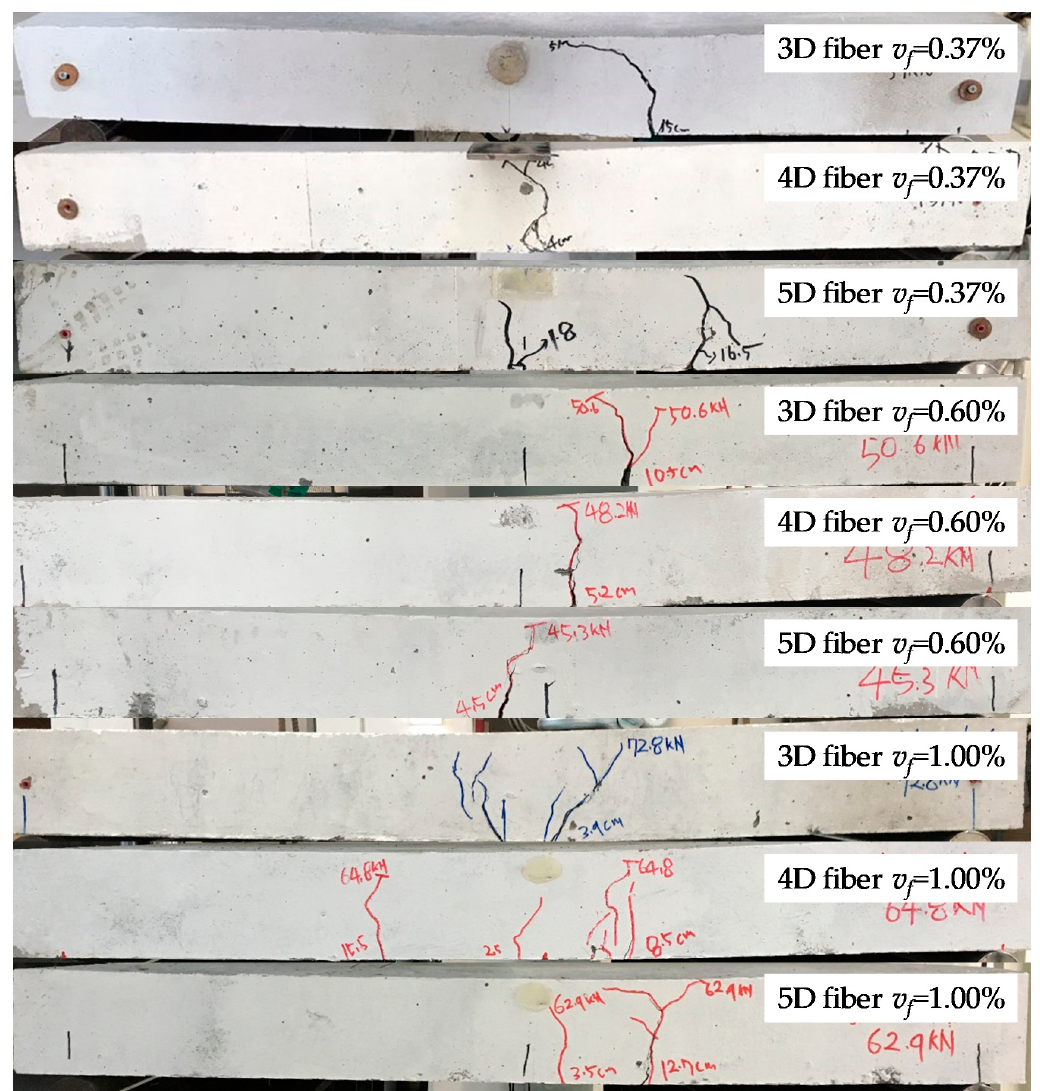
Figure 11. Cracking patterns and failure mode.